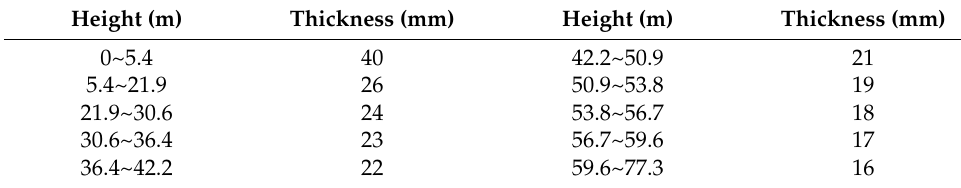
Table 1. Parameters of the wind turbine tower [24].